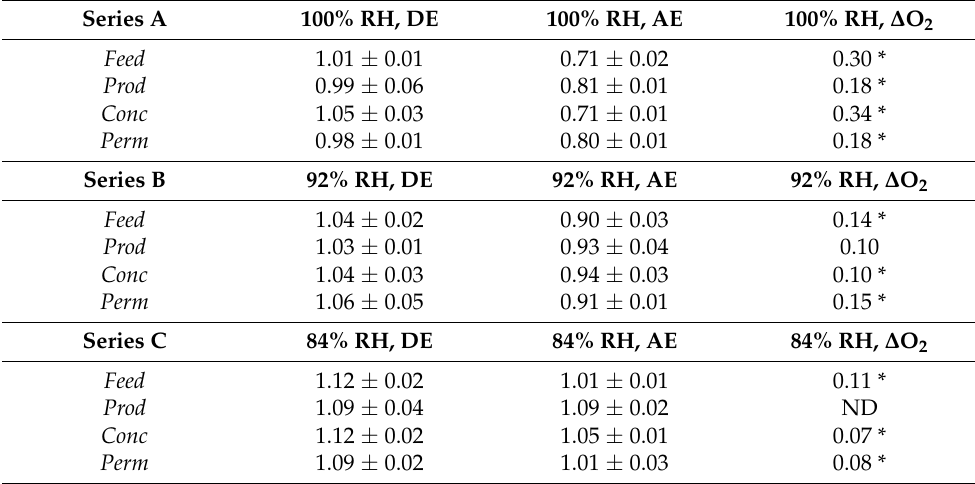
Table 4. Oxygen content (in %) and differences ( ∆ ) in oxygen content between deactivated enzyme (DE) and active enzyme (AE) after five days at different relative humidity (RH) a